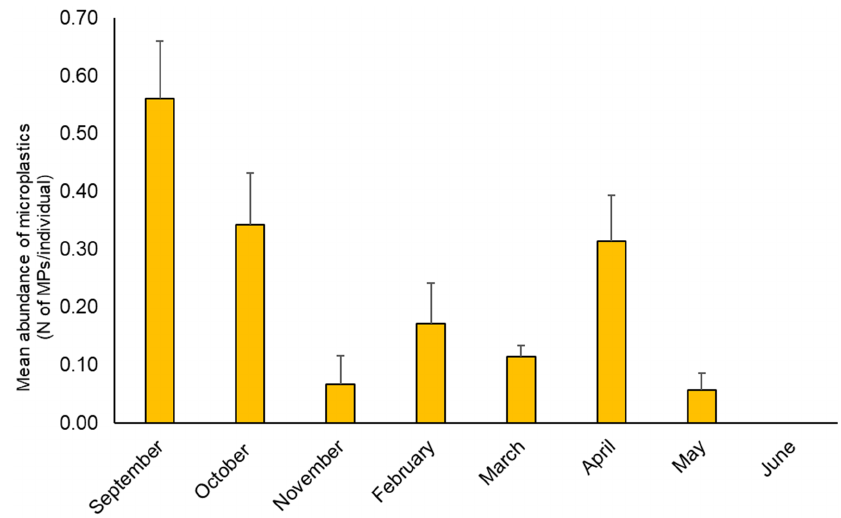
Figure 2. Mean abundance of microplastics (number of MPs/individual) accumulated in wedge clams sampled during each monthly sampling.